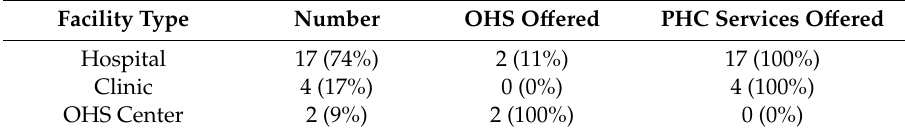
Table 3. PHC services and OHS o ff ered by the health institutions.